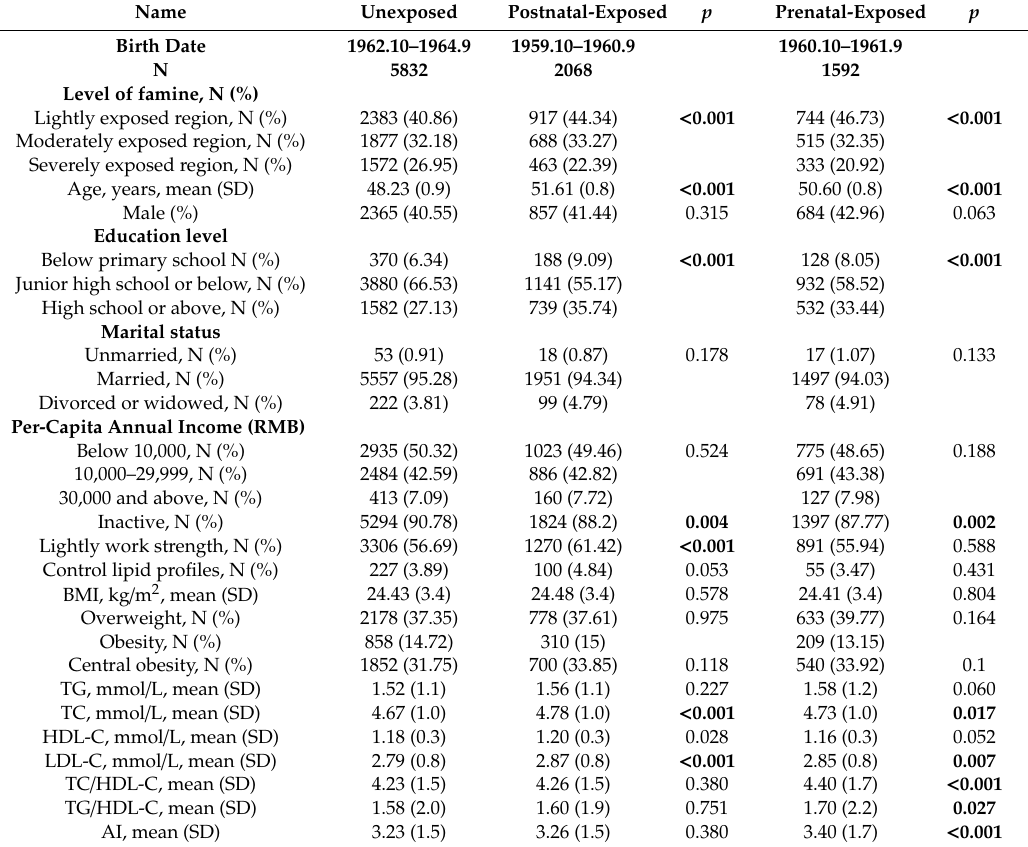
Table 3. Characteristics of study population according to Chinese famine